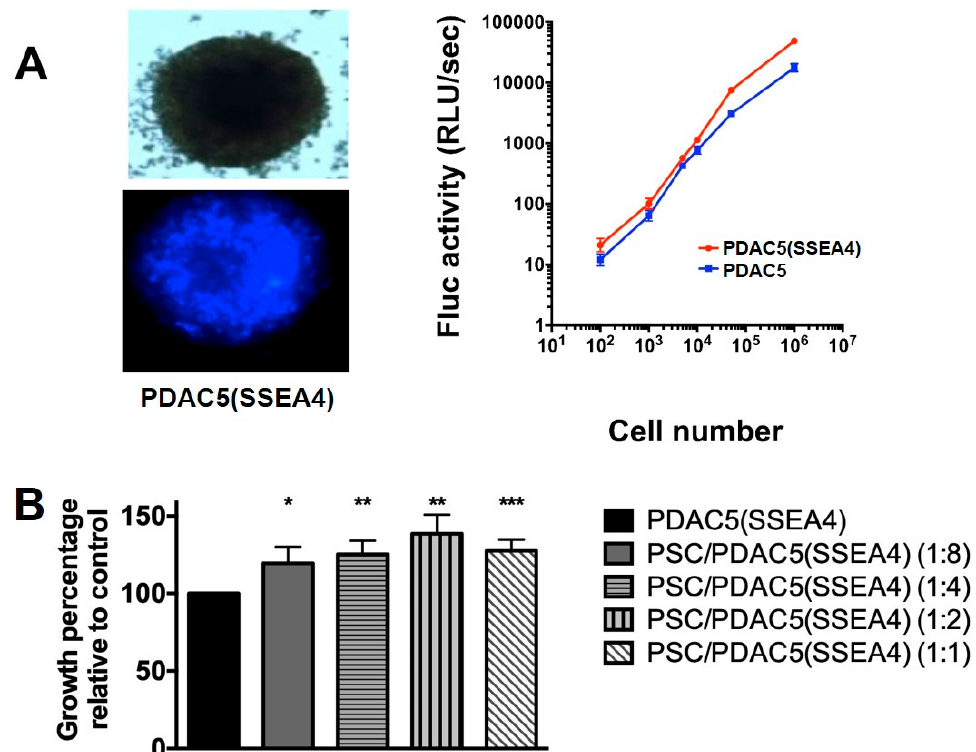
Figure 5. Evaluation of homo- and hetero-spheroids by luciferase assay. Representative images of a homo-spheroid of primary PDAC5 cells sorted for SSEA4 (PDAC5 (SSEA4)) ( A , left upper image, bright field; left lower image, fluorescence microscopy for CFP. Analysis of luminescence showed that the increase in the BLI signal of Fluc correlates directly with the increasing number of cells ( A , right panel); y-axis: relative light units per second (Rlu / s). This experiment corresponds to a single time point (i.e., 24 h after seeding), with di ff erent cell seeding densities. E ff ect of PSCs on proliferation of PDAC5 (SSEA4) cells in 3D culture was determined by luciferase assay and compared to homo-spheroids containing the same number of cancer cells ( B ). PSCs significantly increased PDAC5 (SSEA4) cell growth in PSC / PDAC5 (SSEA4) hetero-spheroids. Data show the mean ± standard error of mean (S.E.M.) of at least four experiments (*, ** and ***: the di ff erence between the hetero-spheroid and homo-spheroid consisting of the same number of cancer cells was significantly di ff erent at p < 0.05, p < 0.01 and p < 0.005, respectively). Abbreviations: PDAC, pancreatic ductal adenocarcinoma; SSEA4, stage specific embryonic antigen-4; CFP, cyan fluorescent protein; BLI, bioluminescence imaging; Fluc, firefly luciferase; PSCs, pancreatic stellate